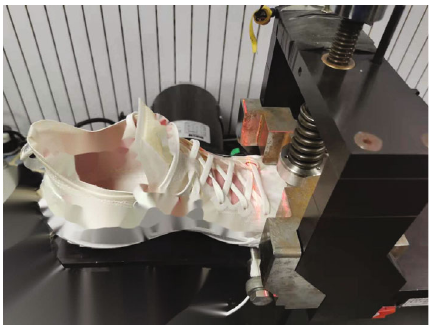
Figure 2: Shoe bending sti ff ness